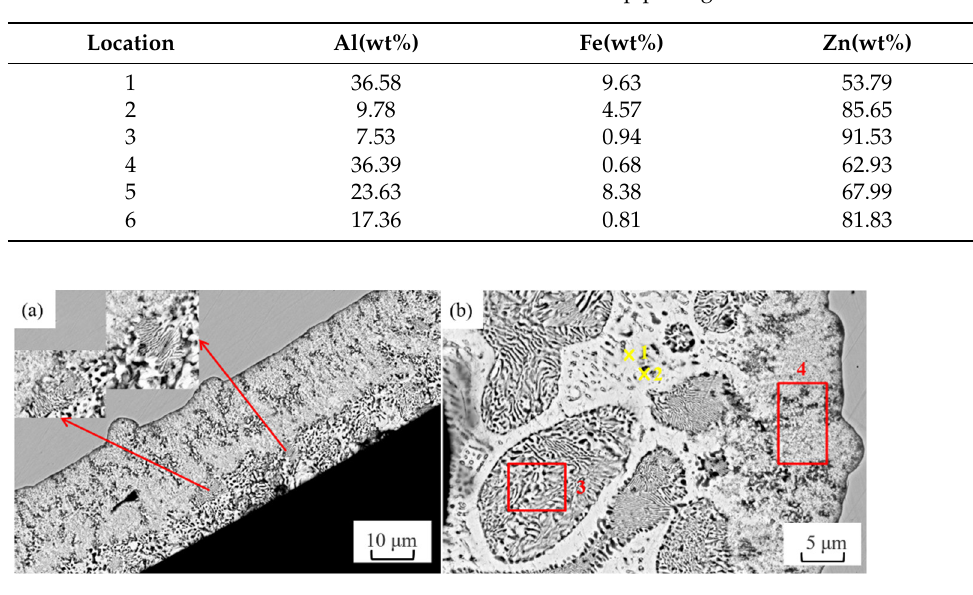
Figure 5. Organization of 475-45-W hot dip plating layer under SEM, ( a ) Cross-sectional morphology of hot dip plating layer tissue; ( b ) Analysis of enriched areas and micro-areas in a large number of lamellar tissue of the reaction layer of hot dip plating layer. Table 8. Point scan and surface scan results of 475-45-W hot dip coating layer.